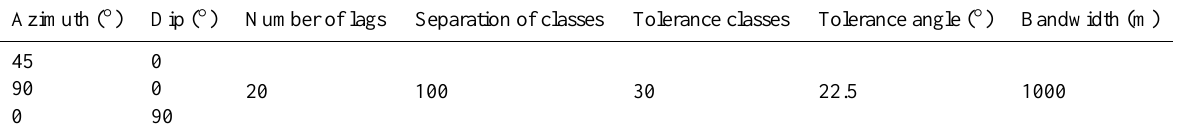
Table 2. Principal directions (variogram analysis).